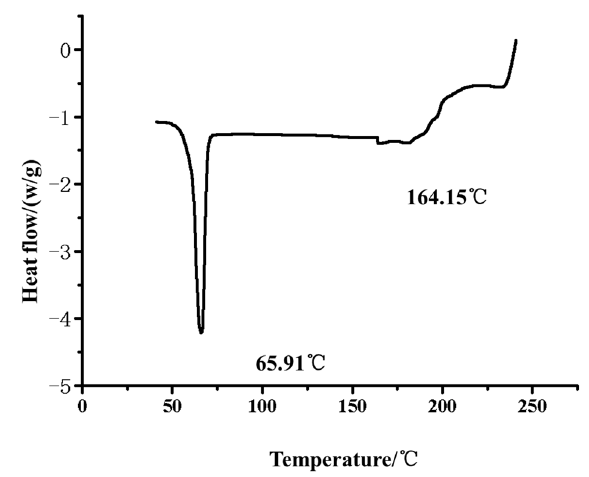
Figure 4. DSC curves of PSVNa.